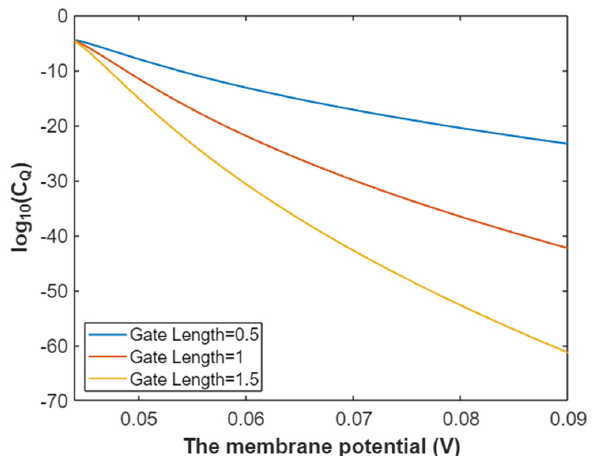
Figure 25. The relationship between membrane potential and the common logarithm of quantum conductance of a single potassium channel for extracellular potassium ions at G = 5.35 J and over a membrane potential range from 0.044 V to 0.09 V.